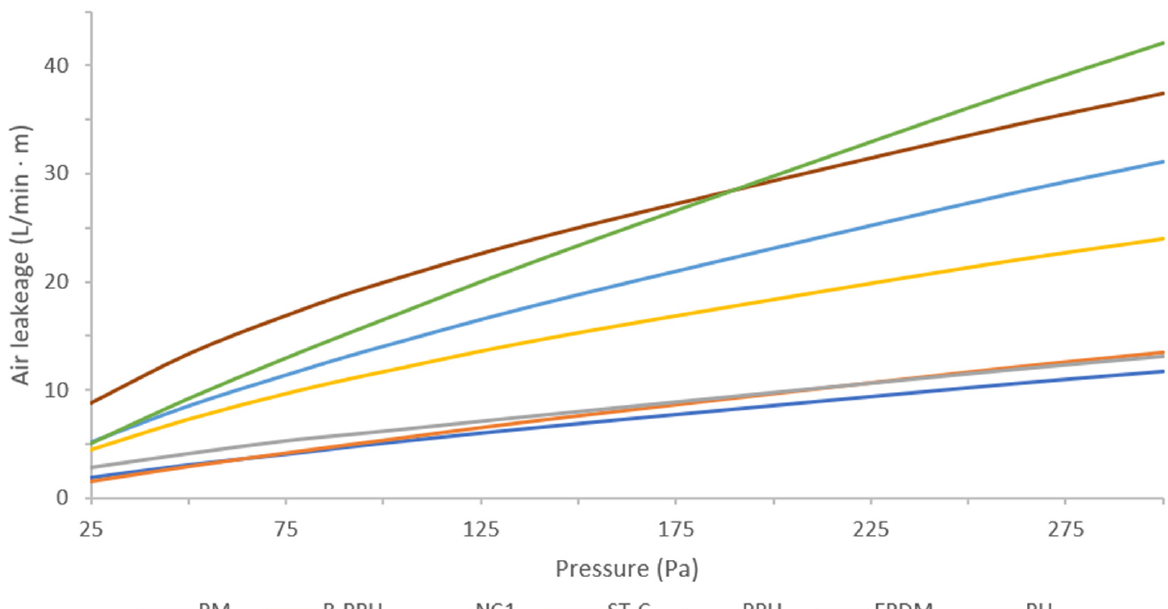
Figure 7. Airflow versus pressure data for materials and structures tested in laboratory.